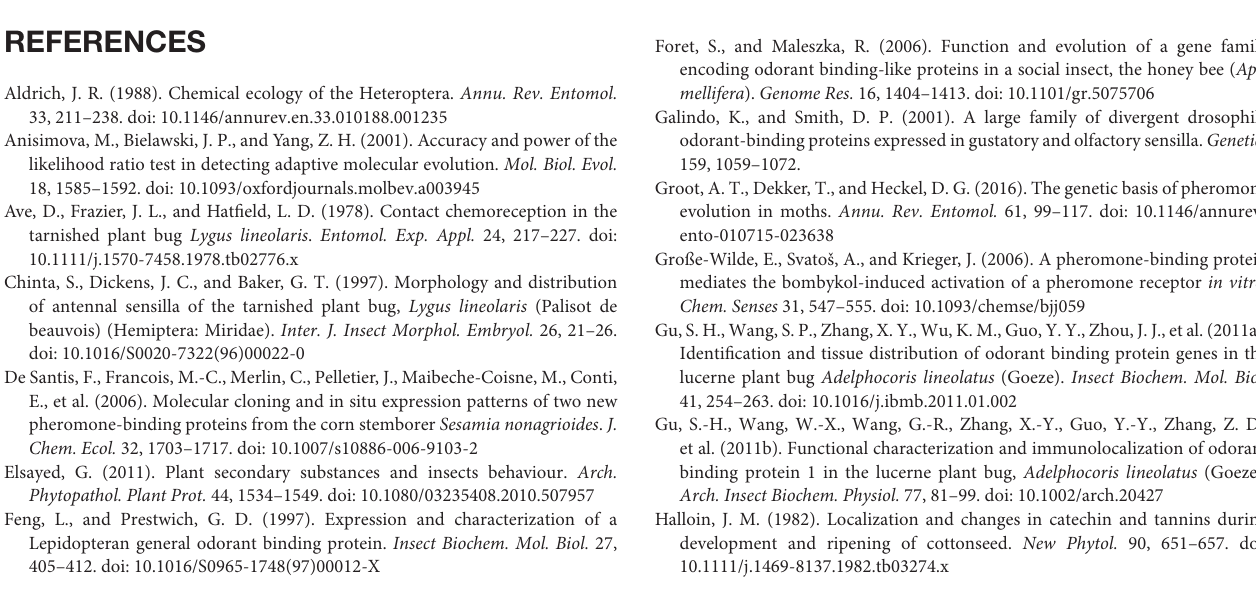
Table S1 | The primers used in this article. Table S2 | The protein names, GenBank accession numbers, and references of OBPs used in the phylogenetic